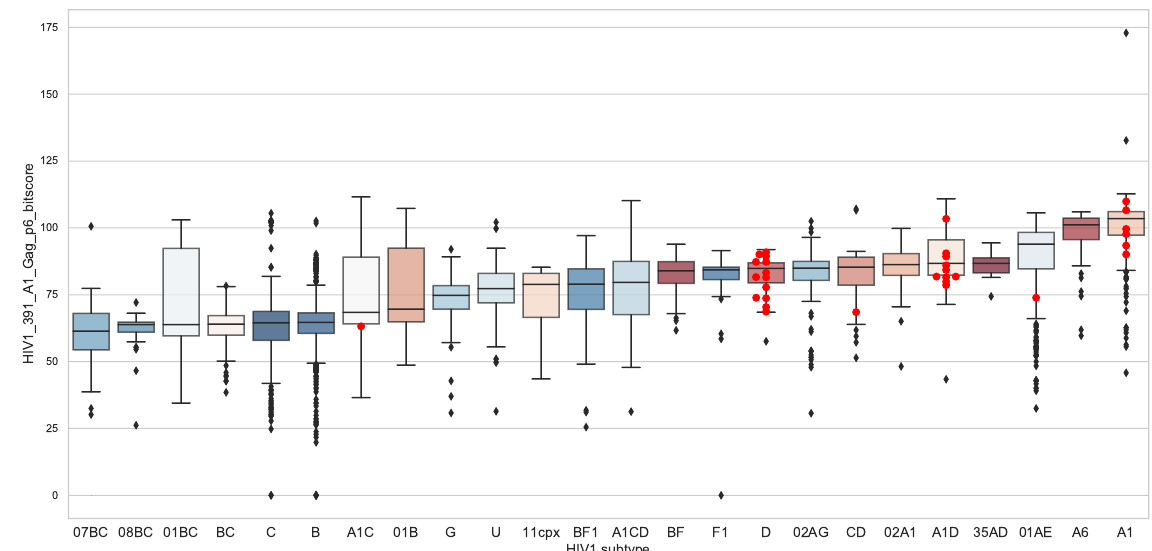
Figure 7. Comparing Gag-P6 bit scores for early infection sequences and all available HIV-1 genomes. All available HIV-1 genome sequences were retrieved from GenBank and classified by subtype using the KAMERIS tool [37]. Gag-P6 Pfam domains were identified and bit scores were gathered. The plot shows standard boxplots of the bit scores, stratified by the 25 HIV-1 subtypes identified in the set of genomes, with first interquartile range indicated by a colored box and the median value for each group indicated by a horizontal line. The Gag-P6 bit scores for the early sequences reported here are shown with red markers in their corresponding subtype. The counts of genomes by subtype were subtype B:7186,